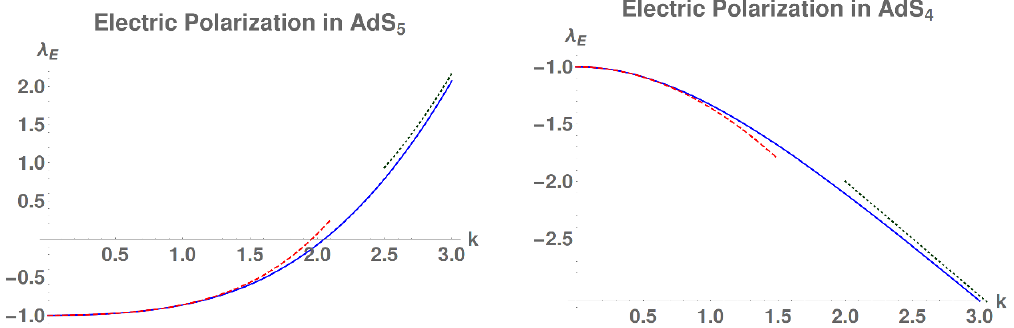
Figure 3 . Electric polarization response of black branes in AdS 5 and AdS 4 as a function of wavenumber k , in units (cid:22) = 1. Solid blue: numerical results. Dashed red: perturbative expansions in powers of k , eqs. (6.15), (6.16). Dotted green: large- k limit